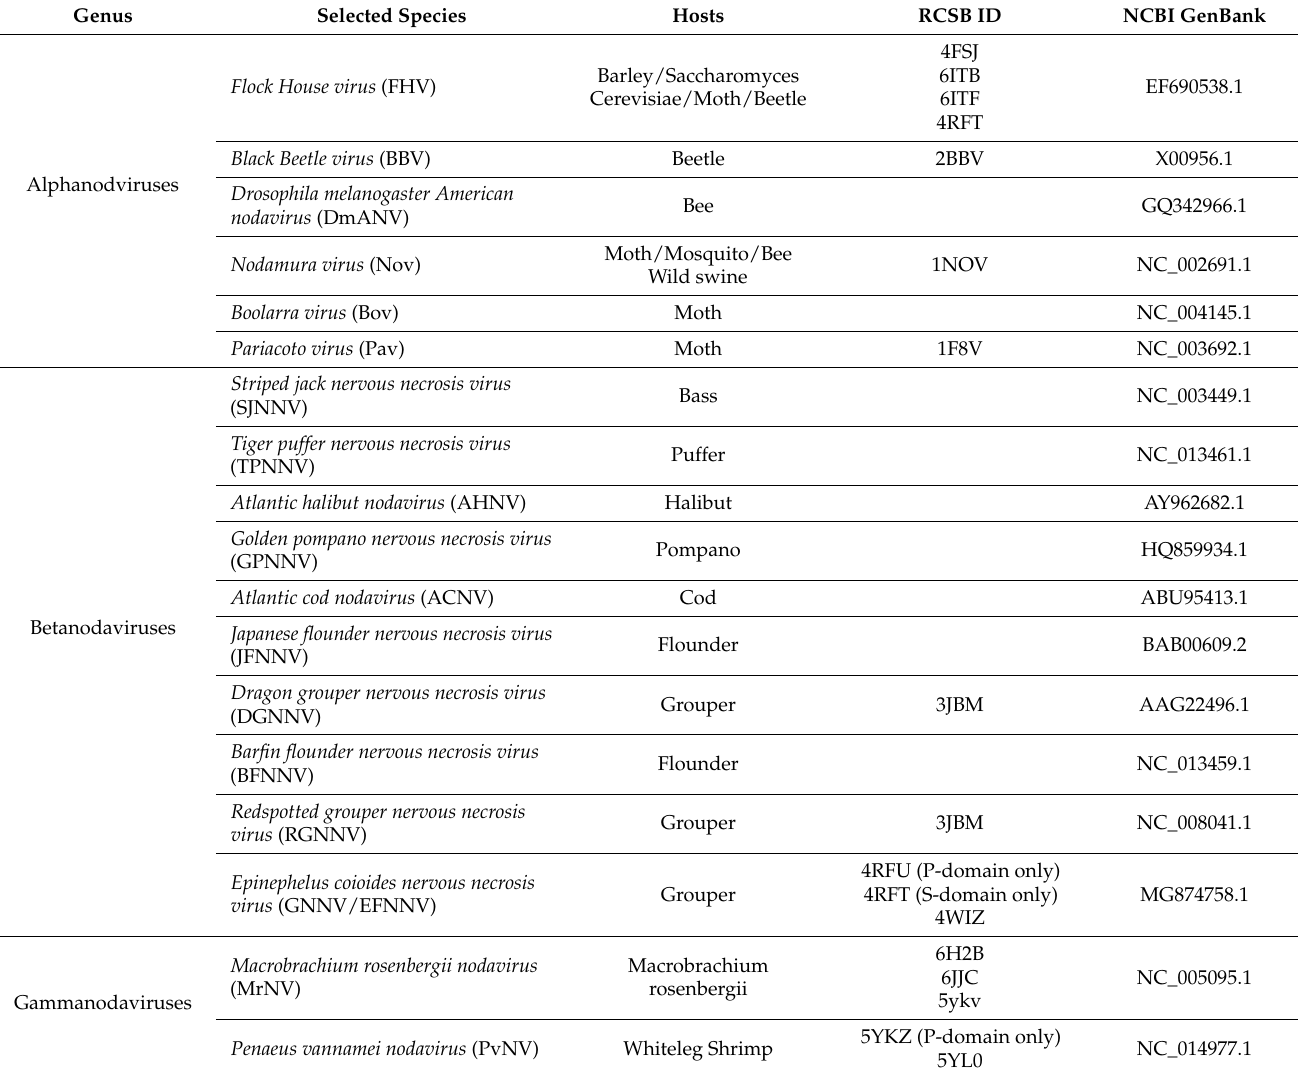
Table 1. Selected genera of the Nodaviridae family and infected host